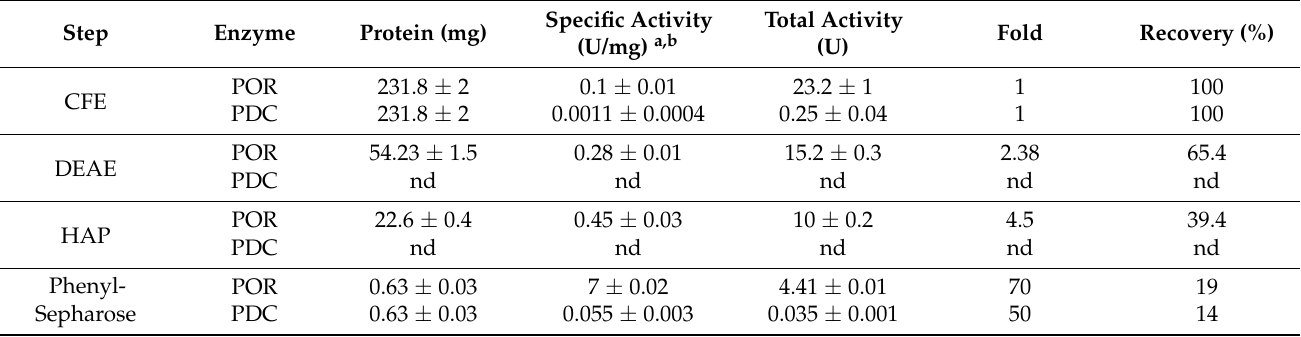
Table 2. Purification of the bifunctional POR/PDC from S. acidocaldarius .